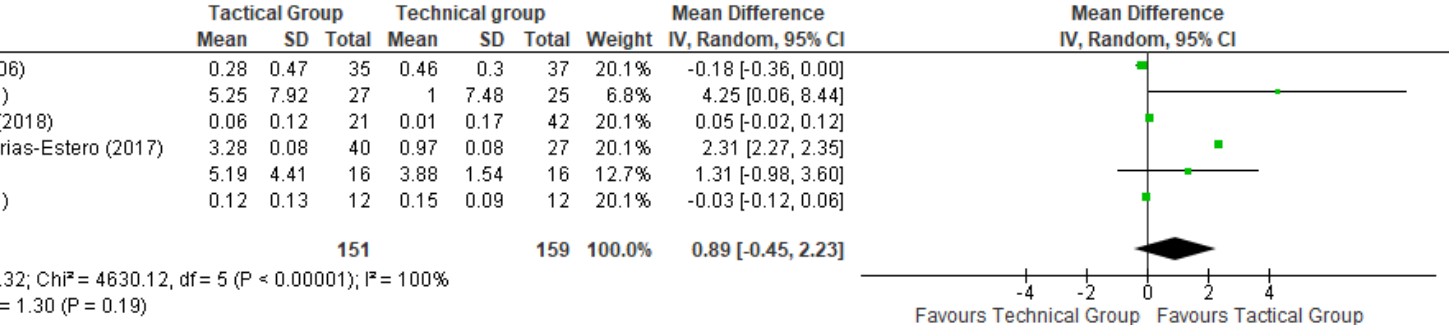
Figure 2. Meta-analysis results of the effects of TEG and TAG on decision making.